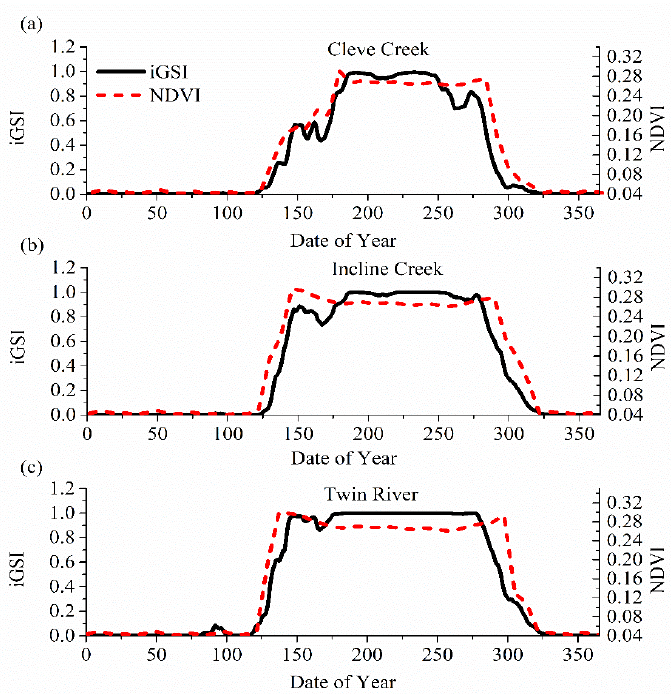
Figure 5. Comparison of seasonal variation of calculated iGSI with the Normalized Difference Vegetation Index (NDVI) obtained from satellite coverage at 16-day intervals for the three watersheds: ( a ) Cleve Creek, ( b ) Incline Creek, and ( c ) Twin River.